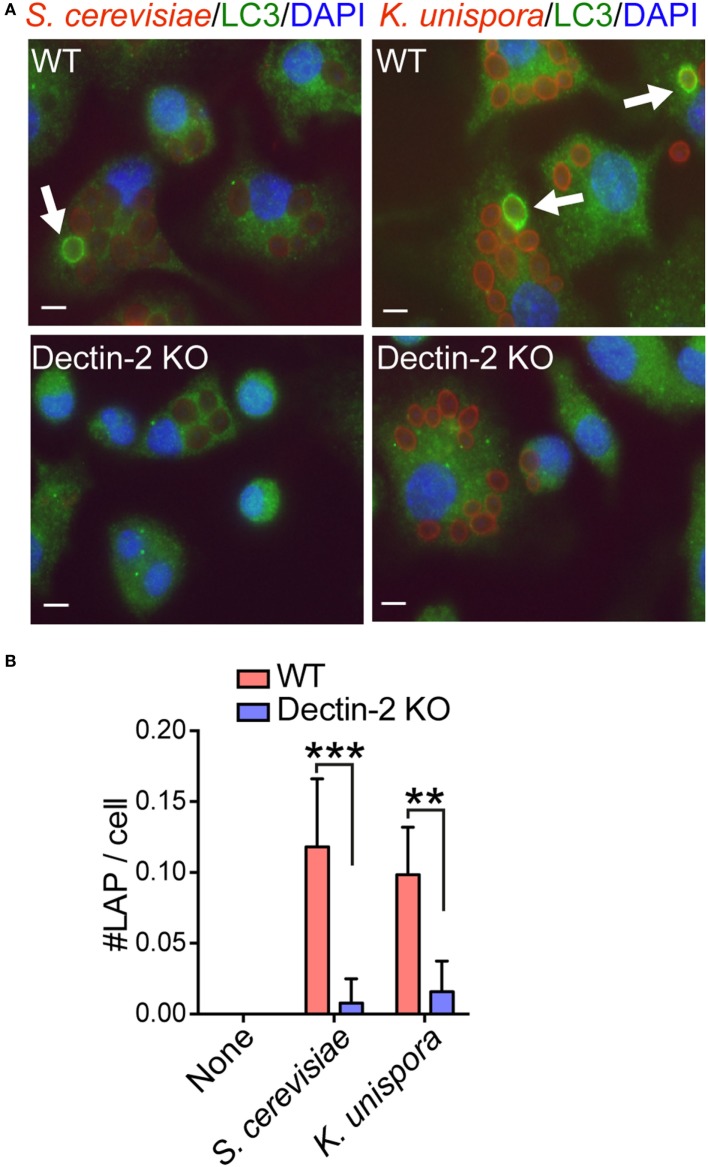
Dectin-2-dependent LAP formation in response to commensal yeasts. (A) WT and Dectin-2 KO BMDCs were incubated with Alexa555-labeled and PFA-fixed S. cerevisiae and K. unispora at MOI 10 for 2 h. White bars indicates 5 μm. Arrows show LC3 recruitment to the yeasts. (B) The number of LAP in the cell was counted around 100 cells per each condition. Data shown are one representative experiment and reproducible in three independent experiments. Statistical analyses were performed by one-way ANOVA followed by Tukey’s test.